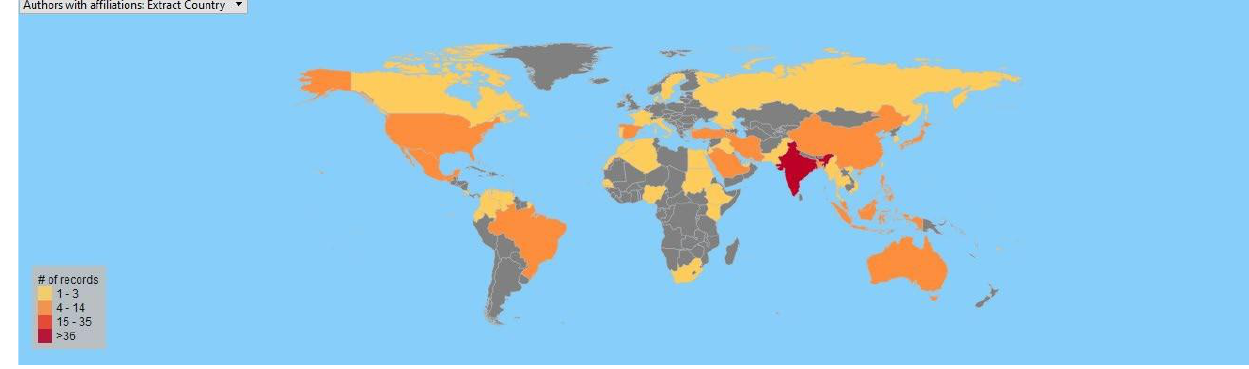
Figure 3. The numbers of publications per country. Obtained using VantagePoint.